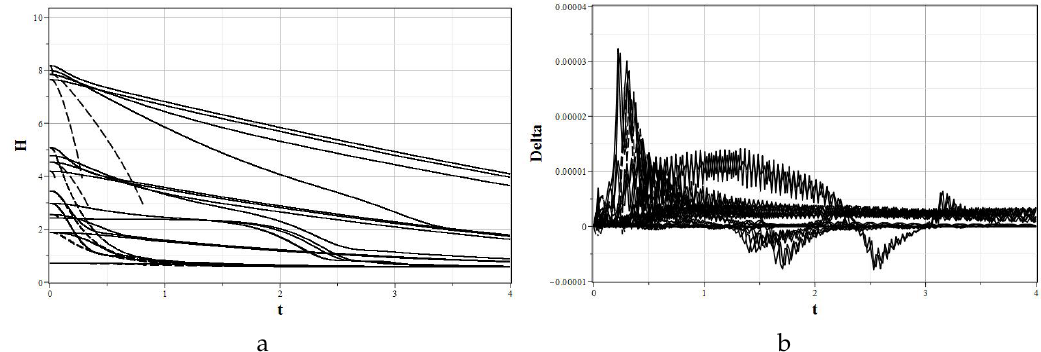
a b Figure 12. Dependence of H on t ( a ); deviation of the integral of motion ∆ ( t ) from zero ( b